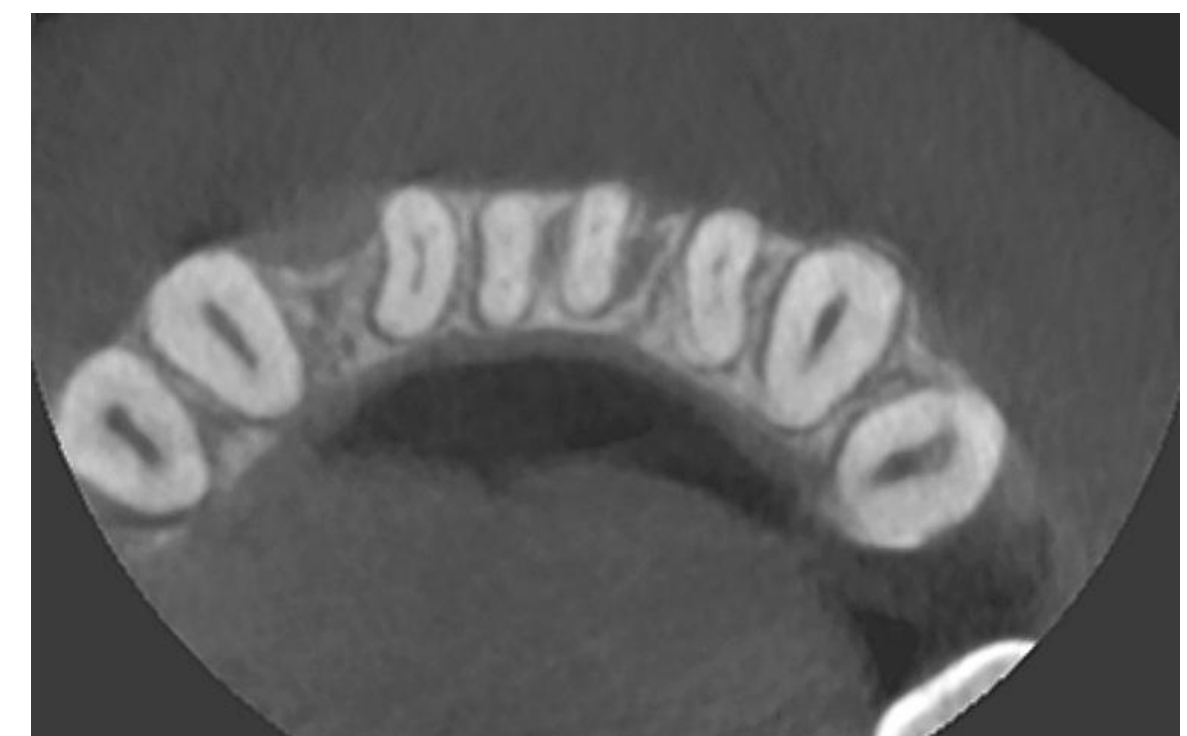
Figure 4. CBCT image before the treatment—axial section.